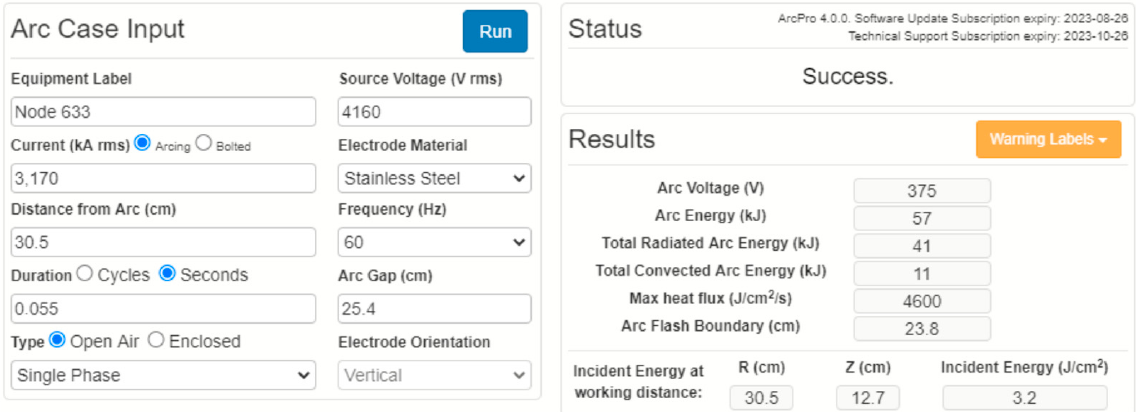
Figure 5. ArcPro simulation results—Case study 1.